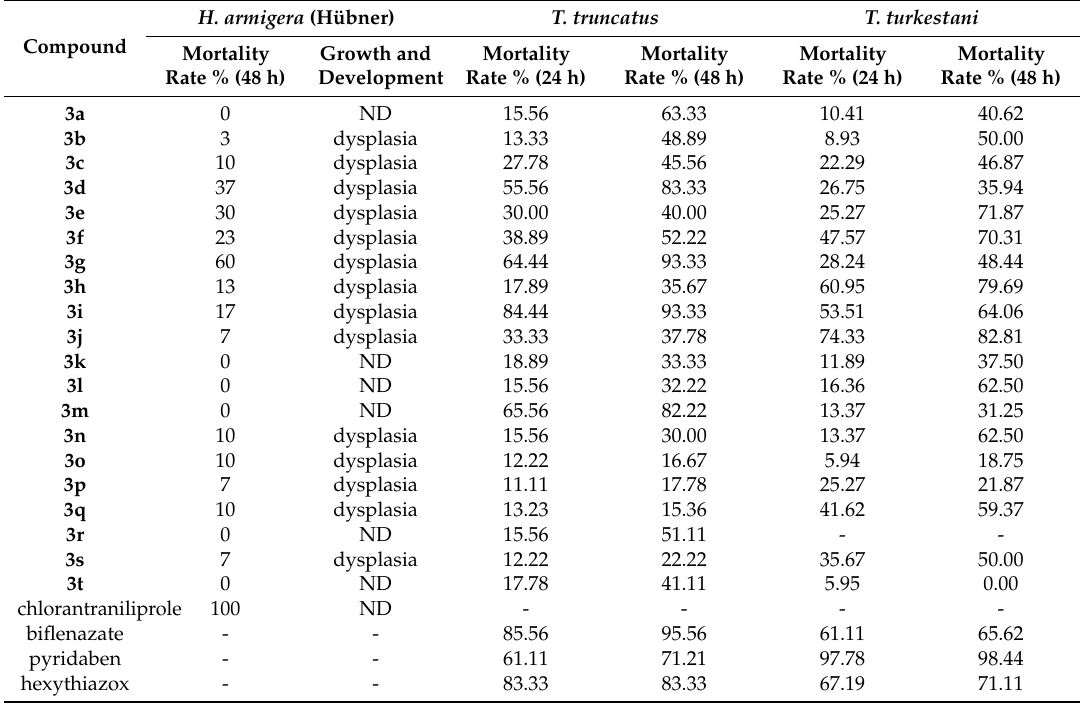
Table 1. In vitro inhibitory activity against the cotton bollworm and the two cotton spider mite species at 50 µ g/mL a,b .